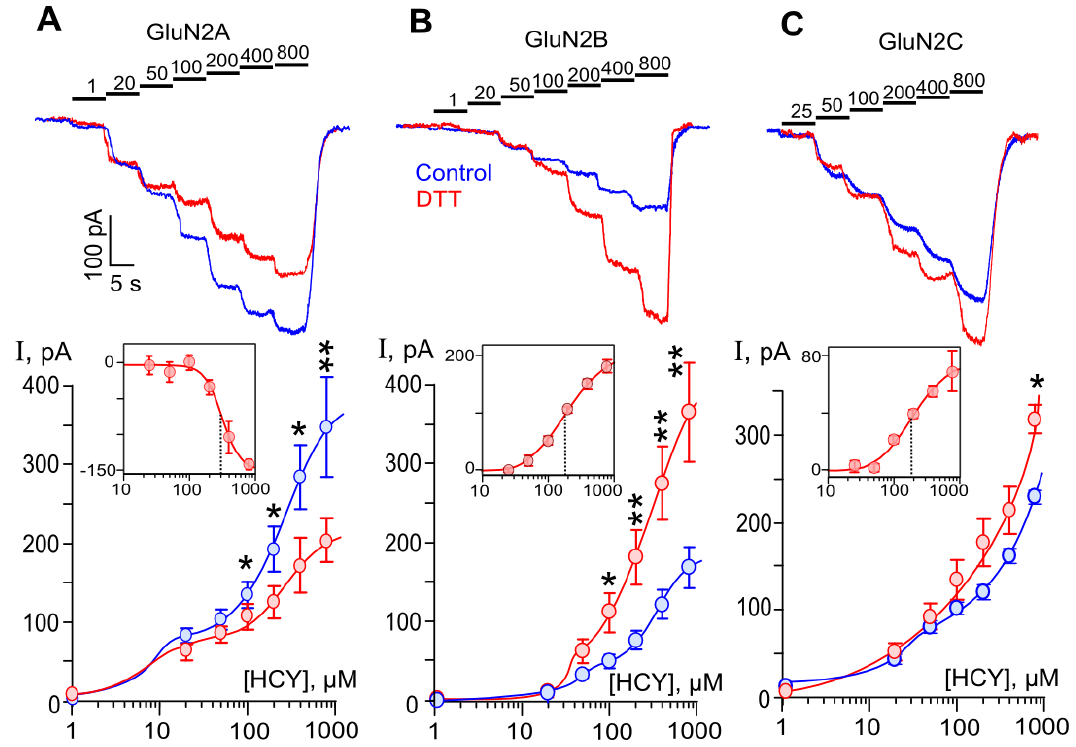
Figure 2. DTT effects on currents activated by HCY through recombinant NMDARs. Concentration dependence of HCY-elicited currents in HEK293 cells expressing GluN1/2A, GluN1/2B, or GluN1/2C NMDA receptors, ( A – C ), correspondently. (Top panels) Currents elicited by HCY concentrations (indicated above the records in μ M) in control (blue) and after 90 s treatment with 1 mM DTT (red) recorded at V h = − 70 mV. (Bottom panels) Concentration-response curves obtained in control (blue) and DTT-treated cells (red) expressing GluN1/2A ( n = 8), GluN1/2B ( n = 9), and GluN1/2C ( n = 15) NMDARs. Data are significantly different from control by Student's t -test in GluN1/2A ( p = 0.03 *, 0.01 *, 0.01 *, 0.004 ** for [HCY]s of 100, 200, 400, 800 μ M), GluN1/2B ( p = 0.01 *, 0.007 **, 0.002 **, 0.001 ** for [HCY]s of 100, 200, 400, 800 μ M), and GluN1/2C ( p = 0.02 * for [HCY] of 800 μ M) NMDARs. Mean values ± SEM are shown. The curves are fitted using biphasic Hill equation. The inserts show the difference between currents obtained at the same [HCY]s by subtracting currents recorded in control from currents recorded after DTT treatment. The curves are fitted using monophasic Hill equation with the following parameters: IC 50 = 308 ± 31 μ M, h = 3.3 ± 0.8 ( n = 5); EC 50 = 180 ± 7 μ M, h = 1.4 ± 0.2 ( n = 6); EC 50 = 185 ± 49 μ M, h = 1.6 ± 0.6 ( n = 6), for GluN1/2A, GluN1/2B, and GluN1/2C NMDARs, correspondently. Mean values ± SEM are shown.